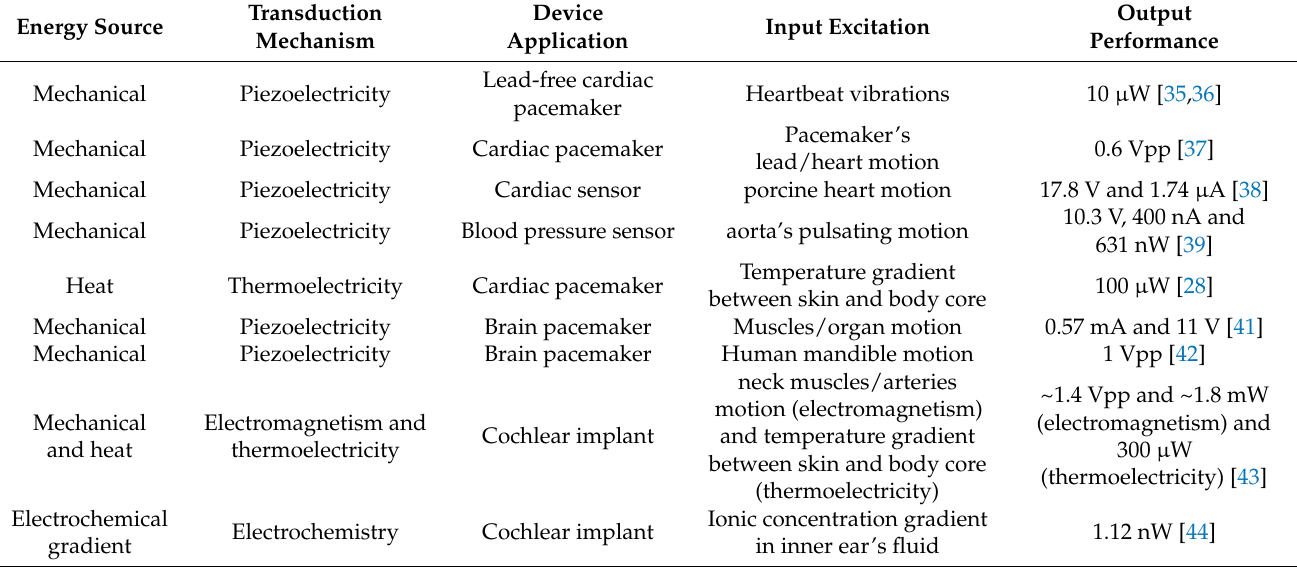
Table 2. Summary of in vivo energy harvesters for implanted medical